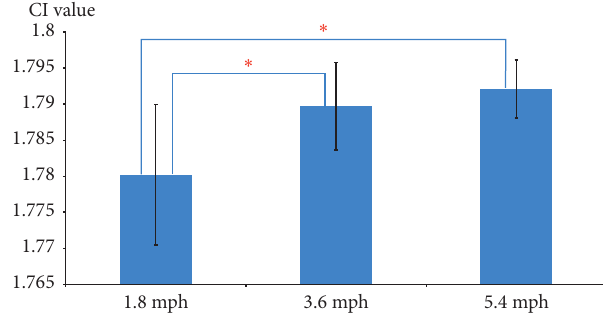
Figure 5: Complexity index of plantar pressure images at the 1 st min during three walking speeds (1.8, 3.6, and 5.4mph). ∗ indicates p < 0 .